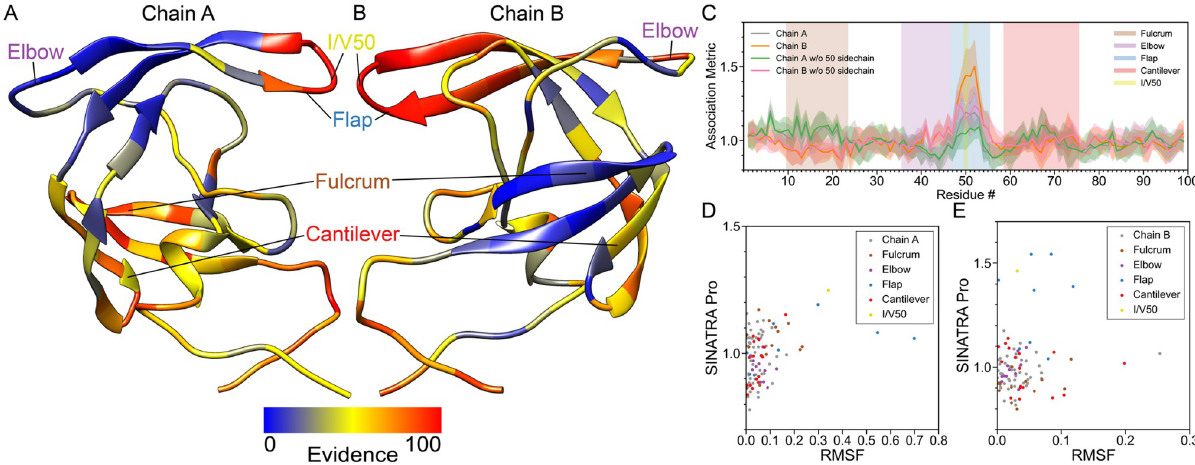
Fig 4. Real data analyses recover structural changes in the flap region of HIV-1 protease driven by a Ile50Val mutation. In this analysis, we compare the molecular dynamic (MD) trajectories of wild-type HIV-1 protease versus Ile50Val mutants (i.e., within residues 47–55). For both phenotypic classes, structural data are drawn from from equally spaced intervals over a 100 ns MD trajectory (e.g., t MD = [0, 1, 2, 3, ... , 99] ns + δ , where δ is a time offset parameter). Altogether, we have a final dataset of N = 2000 proteins in the study: 100 ns long interval × 10 different choices δ = {0.0, 0.1, 0.2, ... , 0.9} ns × 2 phenotypic classes (wild-type versus mutant). This figure depicts results after applying SINATRA Pro using parameters { r = 6.0 Å , c = 20, d = 8, θ = 0.80, l = 120} chosen via a grid search. The heatmaps in panels (A) and (B) highlight residue evidence potential on a scale from [0–100]. A maximum of 100 represents the threshold at which the first residue of the protein is reconstructed, while 0 denotes the threshold when the last residue is reconstructed. Panel (A) shows residue-level evidence potential when applying SINATRA Pro to chain A, while panel (B) depicts results for chain B. Annotated regions of interest are color coded and correspond to the shaded residue windows in panel (C) . Panel (C) shows the association metrics (and their corresponding standard errors) computed for each residue in chains A and B, with and without the 50th residue’s side chain being included in the analysis (see Material and methods). Here, the overlap shows the robustness of SINATRA Pro for identifying the same signal even when it does not have access to the full structure of the protein. The final row plots the correlation between the SINATRA Pro association metrics and the root mean square fluctuation (RMSF) for all atoms with correspondences in (D) chain A and (E) chain B, respectively. Highlighted are all atoms with correspondences found in regions of the protein corresponding to the fulcrum (brown), elbow (purple), flap (blue), cantilever (red), and I/V50 (yellow) [29, 31,